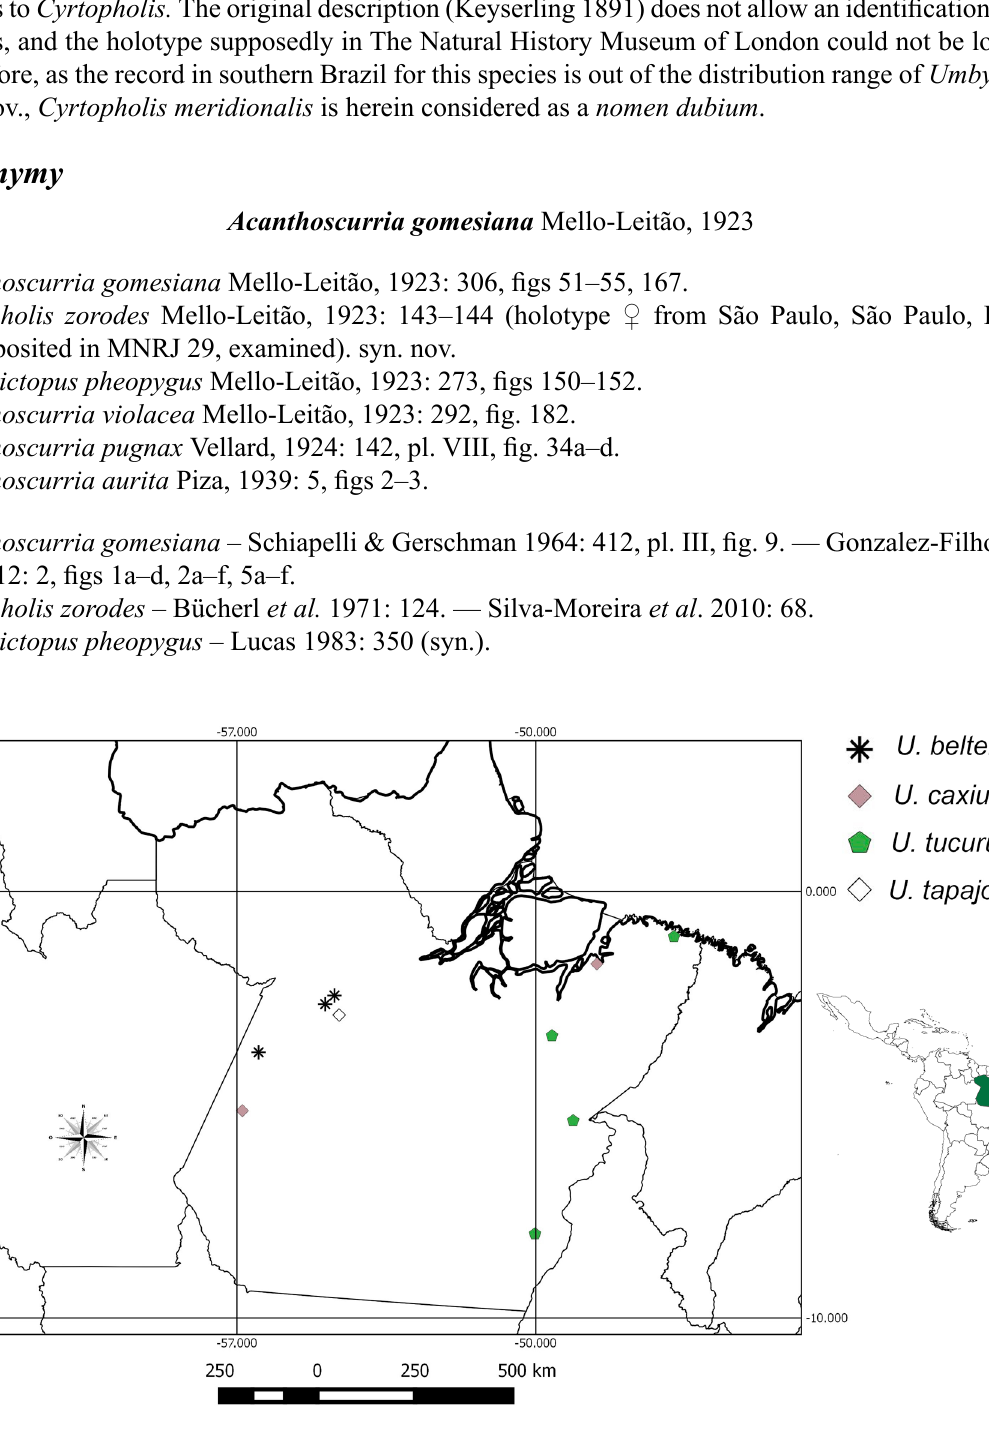
Fig. 29. Geographic distribution records of species of Umbyquyra gen. nov.: U. belterra gen. et sp.